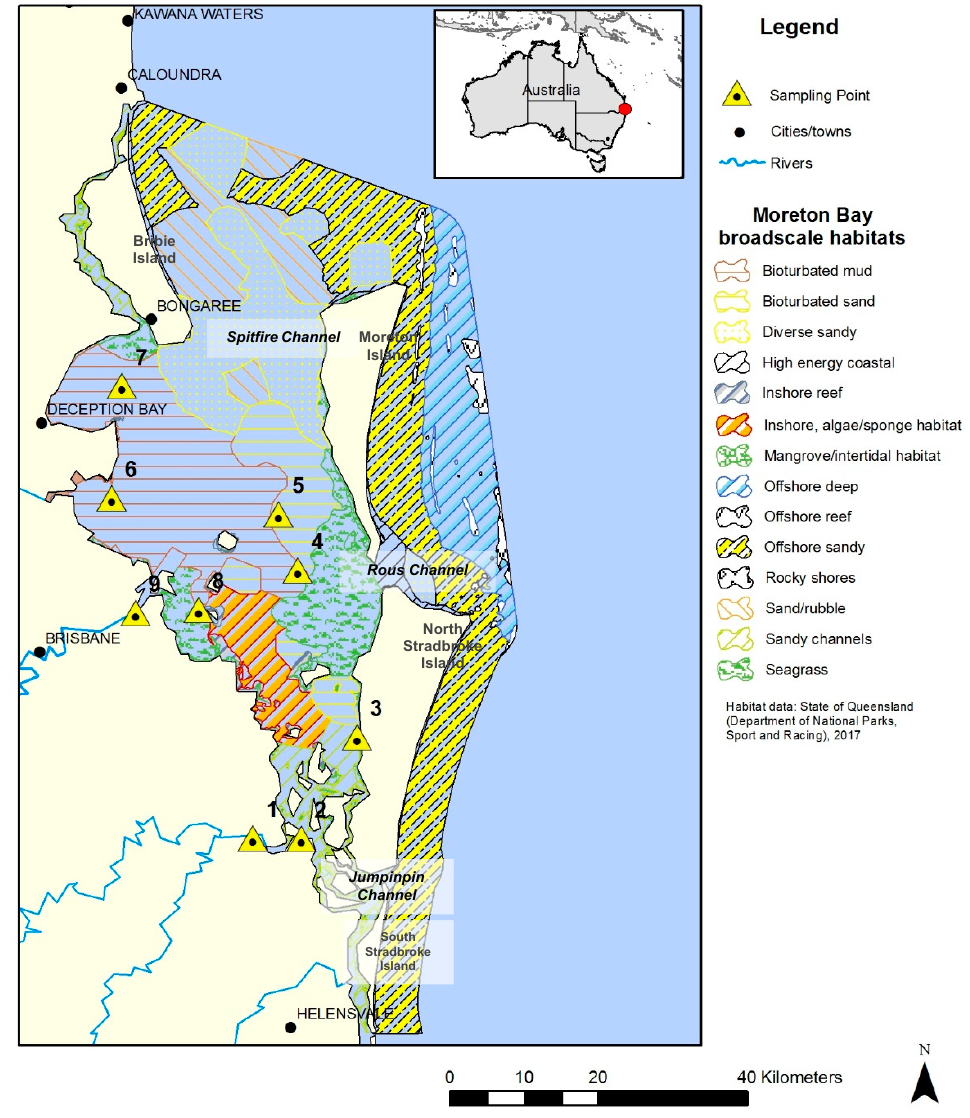
Figure 1. Map of Moreton Bay (South East Queensland, Australia), with its broad-scale marine habitats identified and sediment sampling sites annotated in yellow triangles.